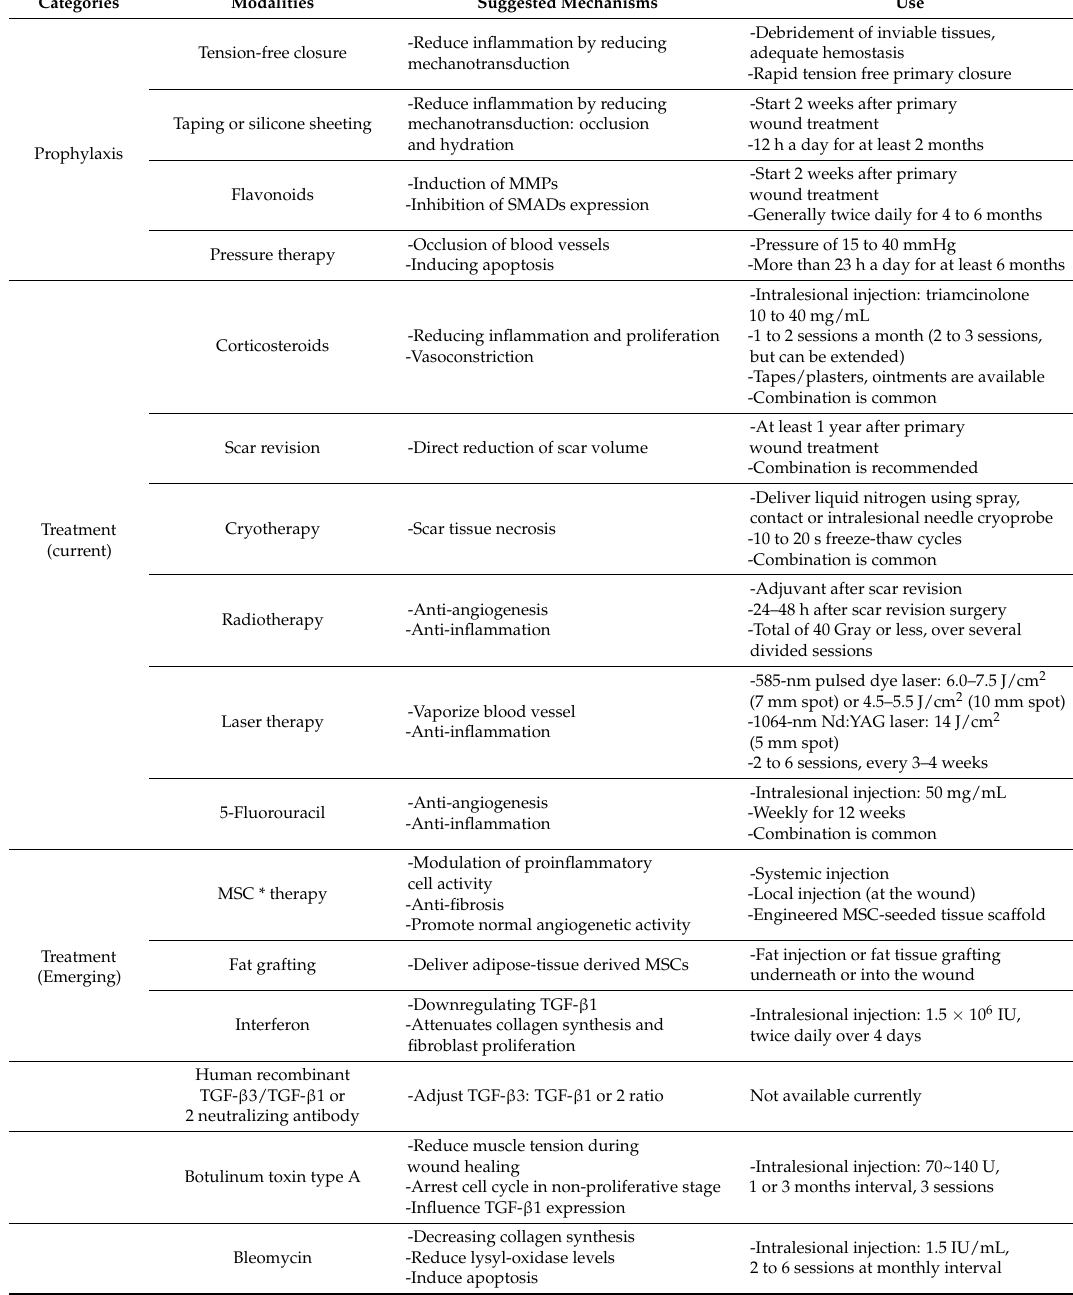
Table 1. Current treatment strategies for hypertrophic scars and